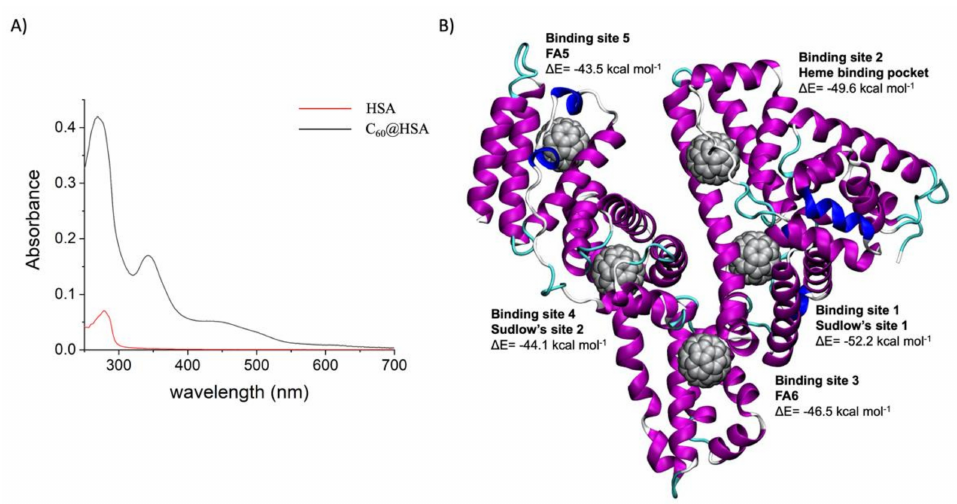
Figure 1. ( A ) UV–visible spectra of C 60 @HSA (black line) and HSA (red line) in PBS. In Figure S1, the UV–visible spectrum of C 60 in toluene is depicted. ( B ) The most probable fullerene binding pocket in HSA, identified by a docking algorithm followed by molecular dynamics